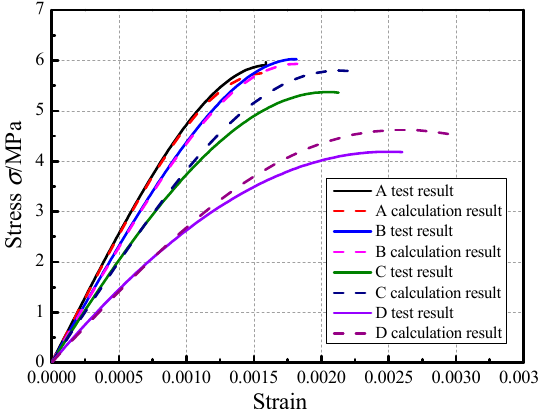
Figure 19. Comparison between proposed analytical models and experimental data for the